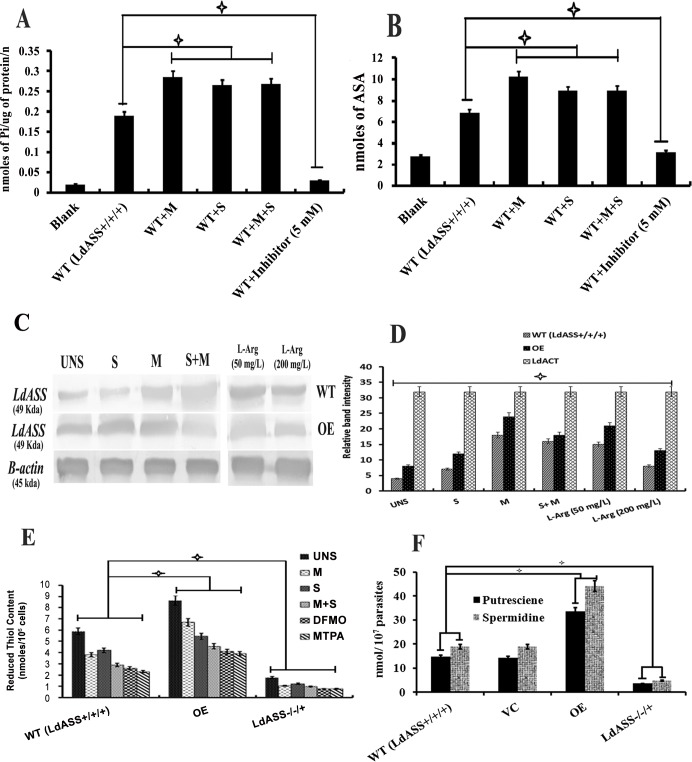
Assay of enzyme activity, argininosuccninate production, western blot analysis, assay of reduced thiol pool and polyamine level.A) ASS enzyme activity of WT L. donovani cell line under stress conditions. Exposing the WT cell line to the stress inducing reagents, menadione (oxidative stress) or a mixture of menadione and SNAP induced a ~1.8-and ~1.5-fold increase in enzymatic activity, respectively was observed. About 100% enzymatic activities were blocked when WT cells were incubated with 5 mM α-methyl-DL-aspartic acid (MDLA), (a specific inhibitor of ASS). B) Bar-graph showing the amount of ASA produced in different in WT L. donovani exposed to different stress inducing reagents. The argininosuccinate levels were increased ~1.5-fold after exposure to different stress inducing reagents in comparison to WT cell line, whereas the level of argininosuccinate was decreased to the level of blank in presence of inhibitor (5 mM MDLA). C) Western Blot image of LdASS of wild type and OE cell lines. Left panel-under different stress conditions i.e. menadione (M), SNAP (S), combination of SNAP and menadione (S+M). Right panel (lanes 5–6) L-arginine limiting conditions after L. donovani cells were cultured in L-arginine free medium for two successive generations. D) Densitometry analysis of the Western Blot results. E) Bar-graph showing the amount of reduced thiol pool in WT, OE and LdASS-/-/+ cell lines under different stress conditions and in presence of two different inhibitors of enzymes involved in polyamine biosynthesis pathway. The reduced thiol level was found to be decreased in LdASS-/-/+ cells by ~3-fold compared to WT and OE cell lines, which were further decreased when exposed to different type of stress. DFMO and MTPA were used as inhibitor of ornthine decarboxylase (ODC) and spermidine synthase (SPS) respectively. Reduced thiol level was found to be decreased in LdASS-/-/+ cell line and under stress conditions. F) Bar-graph showing the relative level of two polyamines i.e. putrescine and spermidine in different L. donovani cell lines (WT, VC, OE and LdASS-/-/+). The level of both the polyamines in the LdASS-/-/+ was found to be decreased by ~4 fold compared to WT parasites whereas ~2.4 fold increased level was observed in OE parasites compared to WT parasites. Each measurement was carried out in triplicate and data are expressed as the mean. Vertical lines on top of the bars represent s.e. values and star symbol above the vertical lines denotes significant changes with P<0.005.